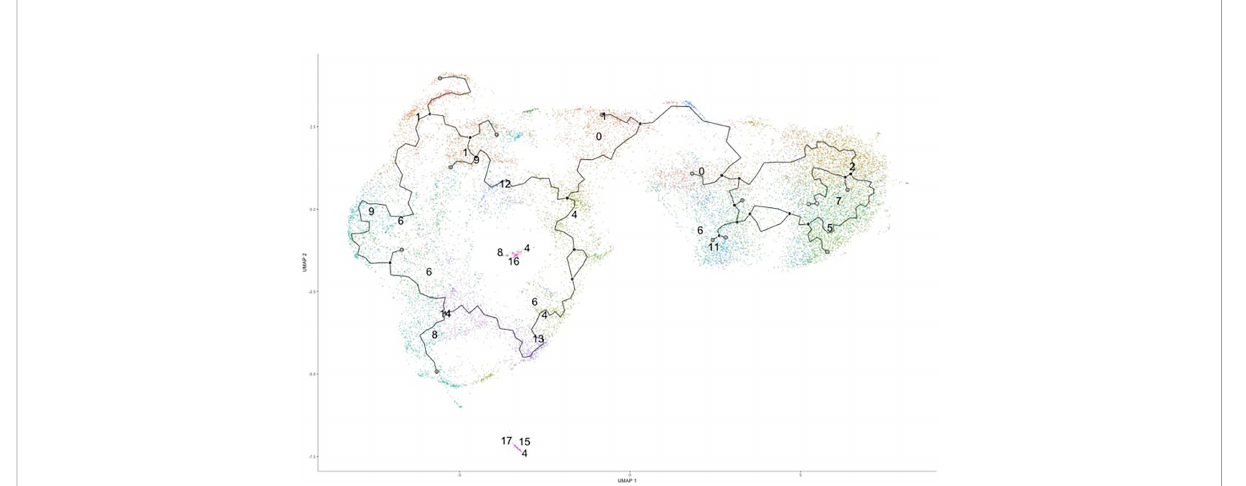
FIGURE 4 Trajectory Analysis Shows Divergent of Clusters into Two Main Groups. Processed human BAL cells were enriched for phagocytic APCs and incubated with C. neoformans strain H99 for 2h and processed for scRNA-seq. Uniform manifold approximation and projection (UMAP) plot was created from the 18 clusters of the infected cohort. From the initial cluster of #0, there is an immediate split of the clusters which follow clusters #1/9/6/12 towards to the left and clusters #2/7/5/3 to the right. Data shown are the 18 Seurat clusters for 22,344 total cells from the infected cohort for three individual experiments for each cohort